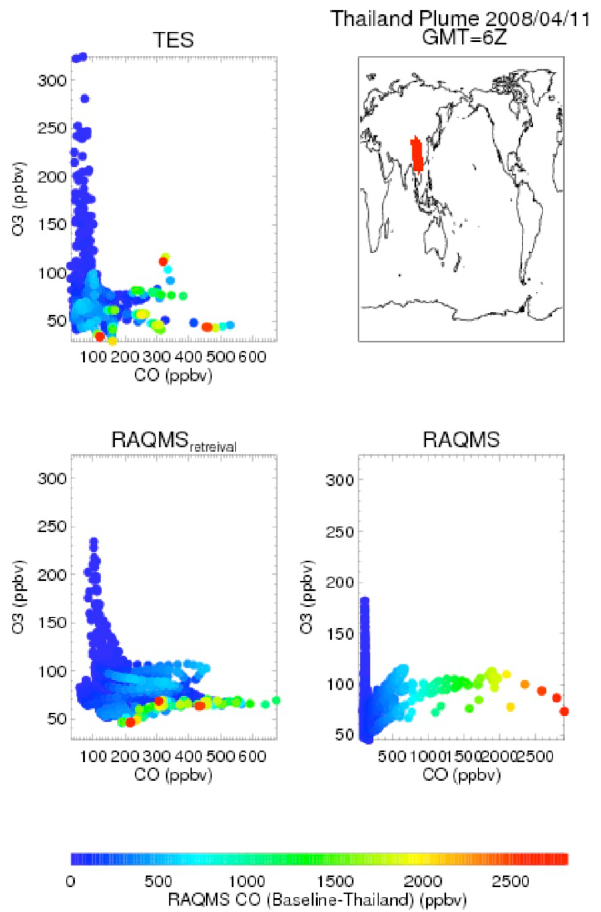
Fig. 11a. Same as Fig. 8 but near source region for Thailand Fires.